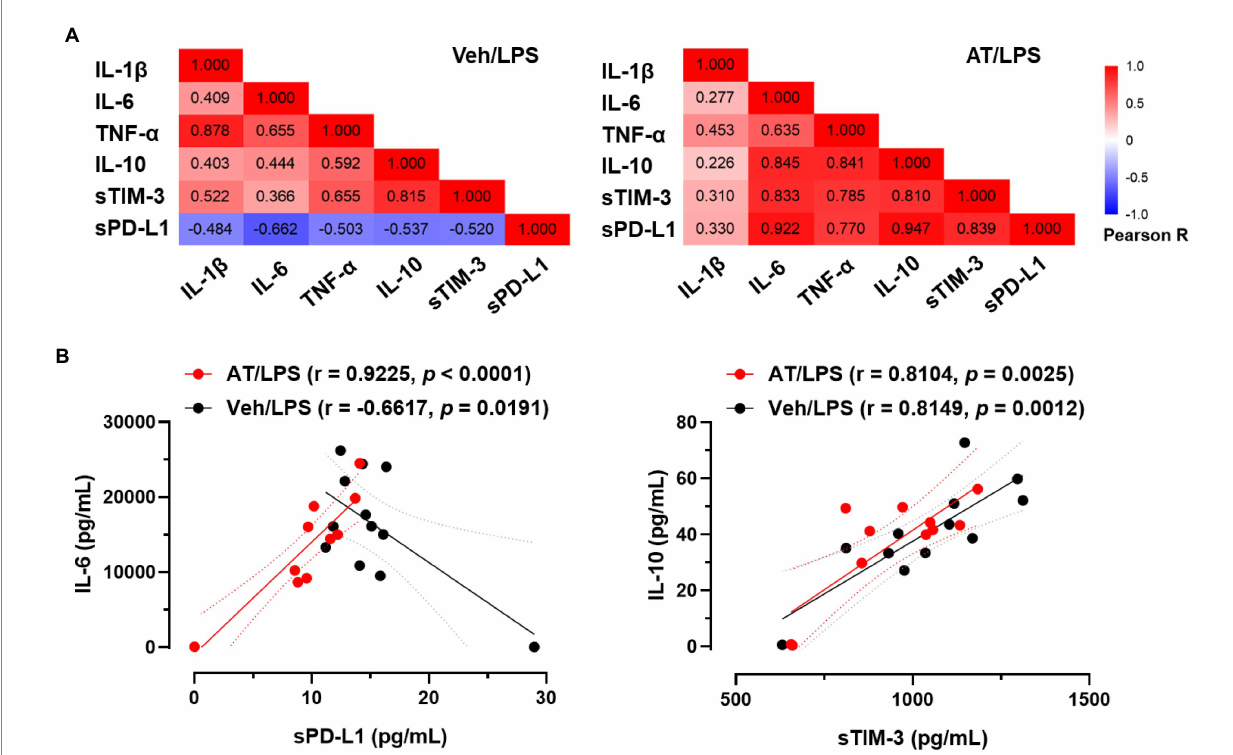
FIGURE 2 Effects of atenolol on the correlation between inflammatory cytokines and soluble immunomodulatory checkpoint molecules in LPS-induced septic mice. (A) Pearson correlation between inflammatory cytokines and sTIM-3 and sPD-L1 in septic mice. Differences in the correlation of individual cytokines and sPD-L1 were observed between septic mice treated with and without atenolol. (B) Correlation analysis of IL-6 and sPD-L1 or IL-10 and sTIM-3 in septic mice in the presence or absence of atenolol